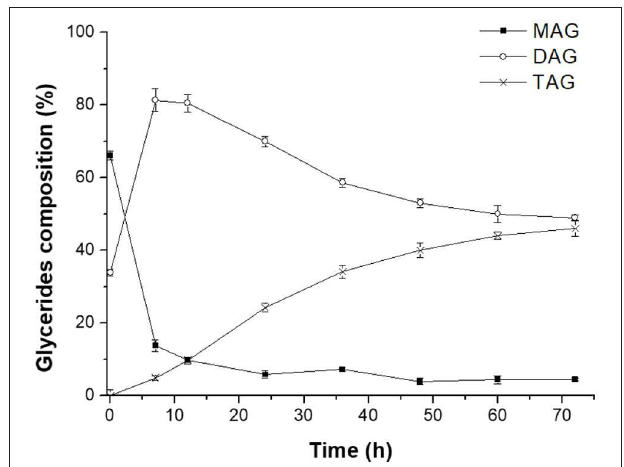
FIGURE 5 | Novozym 435-catalyzed transesterification of heavy phase with DHA-rich EE.